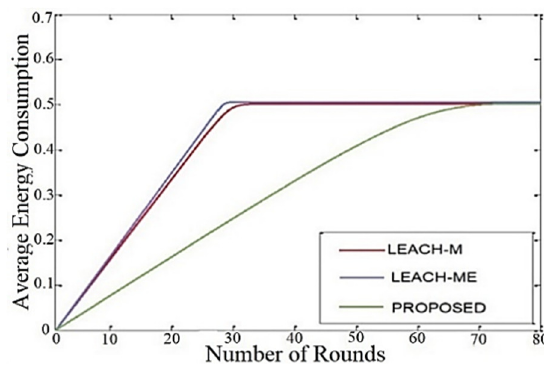
Fig. 13. Dead nodes’ number against rounds’ number.